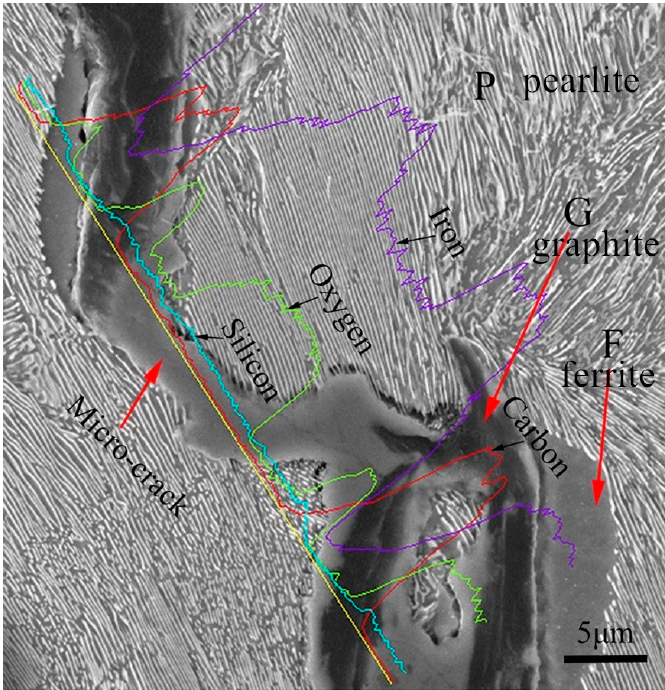
Figure 11. Crack initiation source of gray cast iron and EDS analysis of the elemental composition. The biomimetic unit embedded in the base metal acted as a crack-arresting unit that blocked crack growth. The local structural transformation of the base metal and the change in the temperature difference between the laser irradiation zone and the base metal generate certain types of stress that are conducive to improving surface wear resistance and fatigue resistance. At the same time, the existence of residual stress can reduce the sensitivity of the crack tip to stress as well as offset part of the driving force of the crack. The residual stress values of different models were different when they were processed; consequently, different models were used to measure residual stress. As the penetration depth of x-ray to the metal was about 20 μ m, the stress value measured by the test should be the plane stress value of 20 μ m deep on the surface of the unit. During the measurement, three points were selected along the laser scanning direction in the middle of the melting unit, which were marked as A1, A2 and A3, and three points were selected as B1, B2, and B3 in the phase transition region of the unit. The D φ -sin2 φ curve of each measuring point is shown in Figure 12. Residual stress and its average values were calculated by the stress measuring instrument’s own software according to the slope of the regression line of D φ to sin2 φ . Residual tensile stress in the melting area of the biomimetic coupling unit in the laser scanning